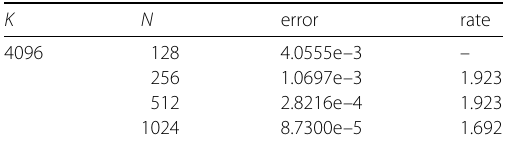
Table 1 Error estimate and convergence rate for the spatial direction with the same parameters as used in Fig. 1(c) K